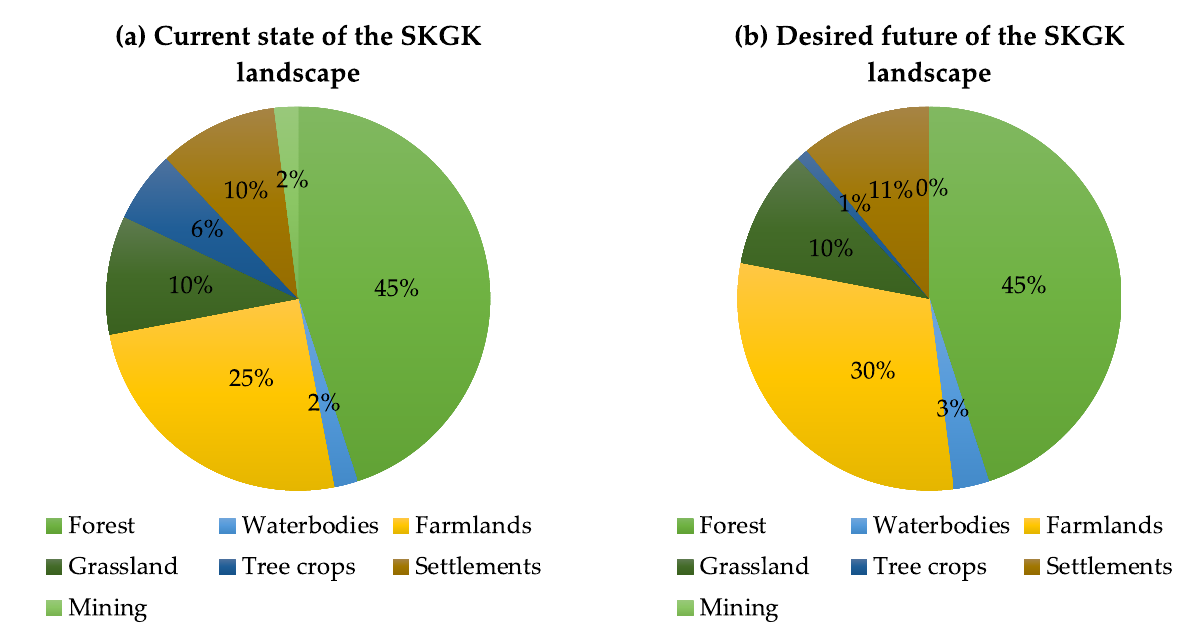
Figure 4. The current state ( a ) and desired future composition ( b ) of the Sanyiga Kasena Gavara Kara (SKGK) landscape as perceived by community actors.